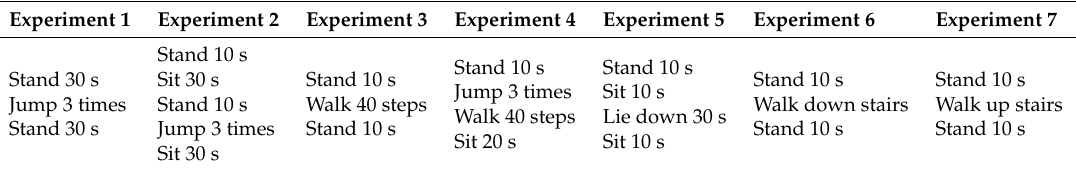
Table 3. Experimental protocol for the HAR dataset.